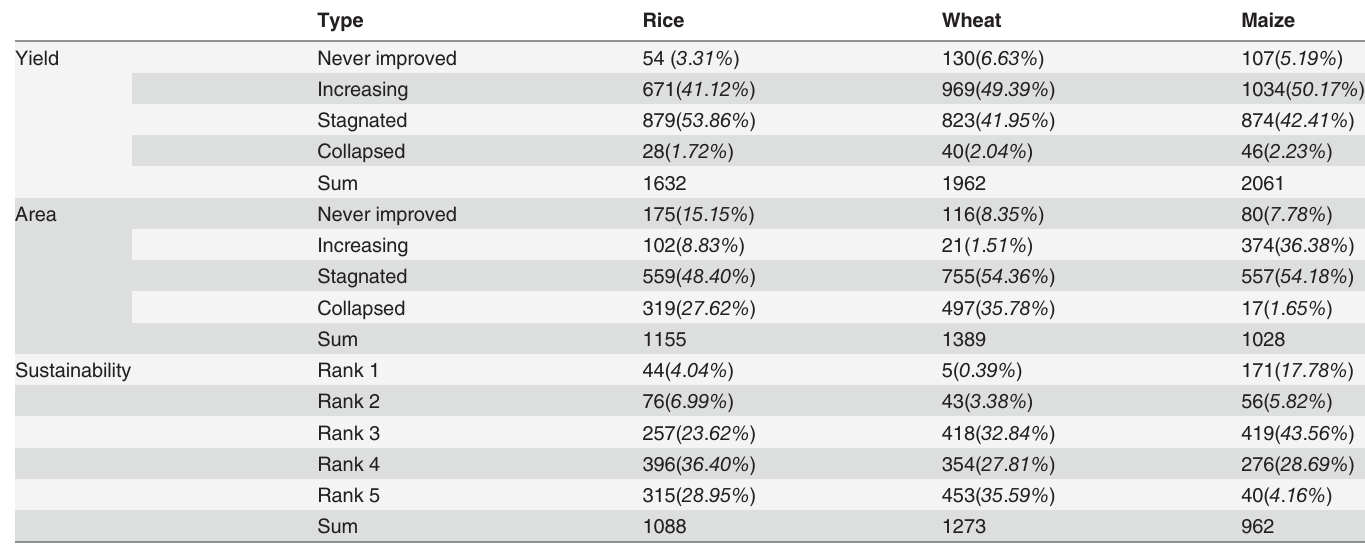
Table 1. Types of trend patterns of yield and planted area and sustainability ranks of